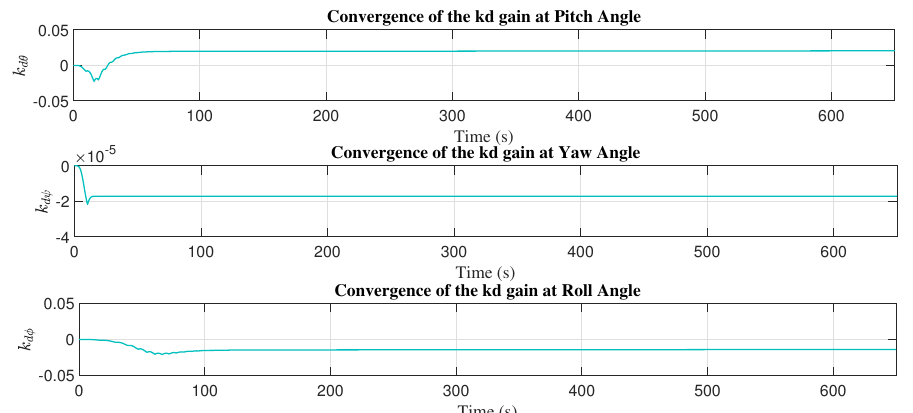
Figure 26. Convergence ˆ k d with MIT rule with high order sliding modes